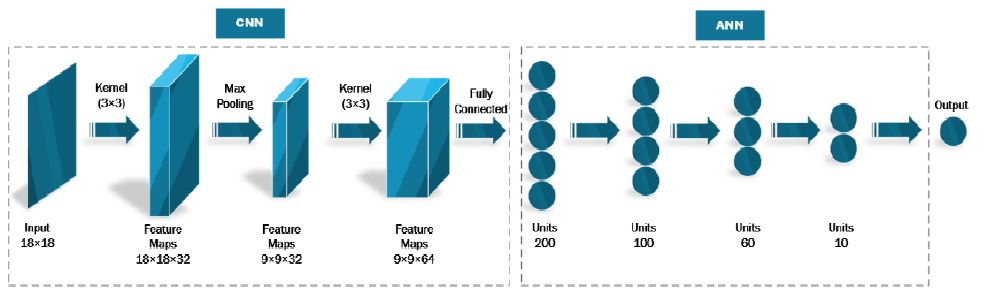
Figure 2. Proposed CNN-ANN Model Architecture.